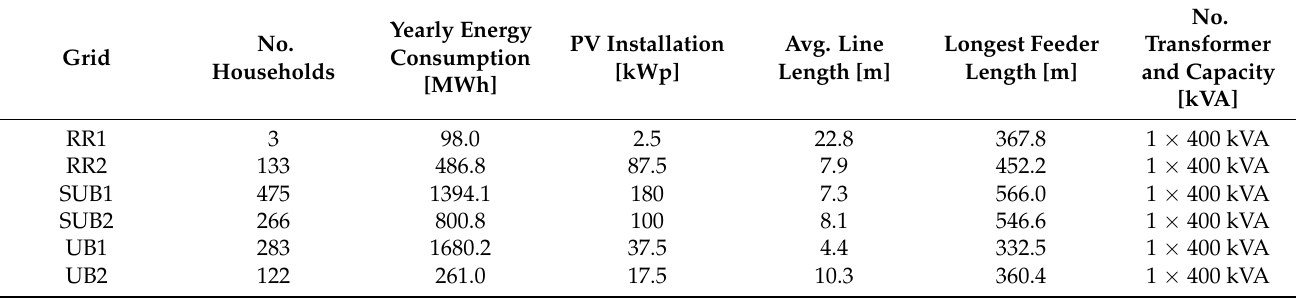
Table 2. Summary of grids’ characteristics.